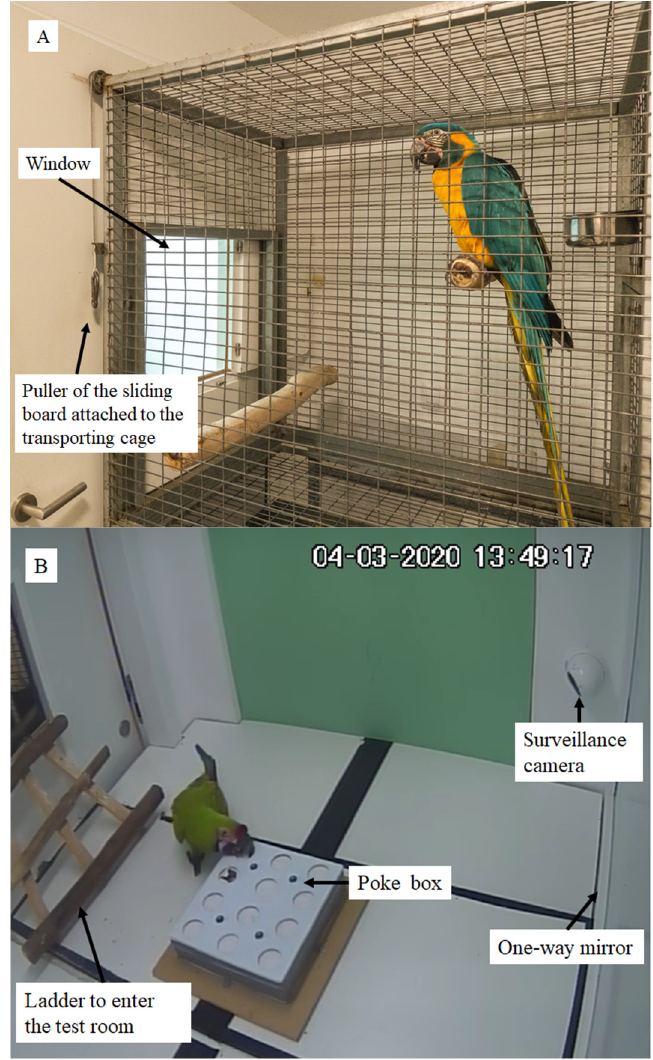
Figure 2. ( A ) Mowgli, a Blue-throated Macaw, in the transporting cage parked next to the door of the test room, with the sliding board of the transporting cage lowered down. The door has a window adjacent to the cage, in which the macaw can enter the test room. ( B ) A screenshot taken from the test room surveillance camera, showing Madame, a Great Green Macaw, completing a trial. The parrots were first habituated to the box and trained to obtain food (seeds) from the wells by tearing paper (Note S2). The main training started once a parrot tore the paper, using its beak, of 10 (out of 12) or more wells for two or more consecutive days. As the parrots appeared to struggle to tear dry paper, we applied a ring of water over each well in a standardised manner to facilitate tearing (but ensured that tearing the paper still required effort), after the box was set up (Figure 1E). In the training phase, two spatial patterns of rewarded wells (A and B; Figure 3) were created. Pattern A consisted of the two columns at the outer edges of the box (6 wells), whereas pattern B consisted of the two middle columns of the box (6 wells). The parrots experienced three trials of each pattern for three consecutive days (see below for further information). The pattern was then switched for the next 3 days of the week, with no testing on the last day of the week. We counterbalanced the pattern that individuals experienced first, within each species. The order of presenting the patterns was fixed for each individual across the training